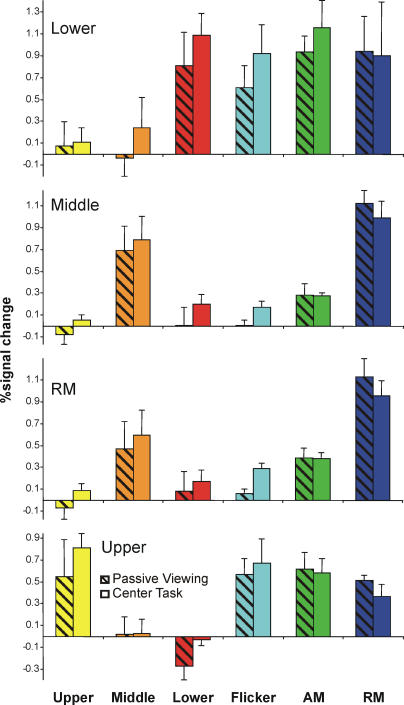
Response Profile for Different ROIs in V1 for Experiment 2The four panels correspond to four ROIs that were defined in V1 by the respective conditions. To determine the ROIs for the three mapping conditions—upper, middle, and lower—the relevant condition was contrasted with the remaining two mapping conditions in a conjunction analysis (e.g., upper > lower and upper > middle). For the real-motion ROI, the real-motion condition was contrasted with the upper and lower mapping conditions (conjunction analysis). The bars designate percentage signal change of the peak response relative to baseline for the different conditions (see Materials and Methods). The hatched bars are activations from runs with passive viewing only, and the solid bars are from runs with center task. For both the real-motion and middle ROI, the response to the apparent-motion stimulus is significantly larger than the response to the flicker squares. This is not the case for the upper and lower ROIs. Error bars correspond to standard errors of the mean.